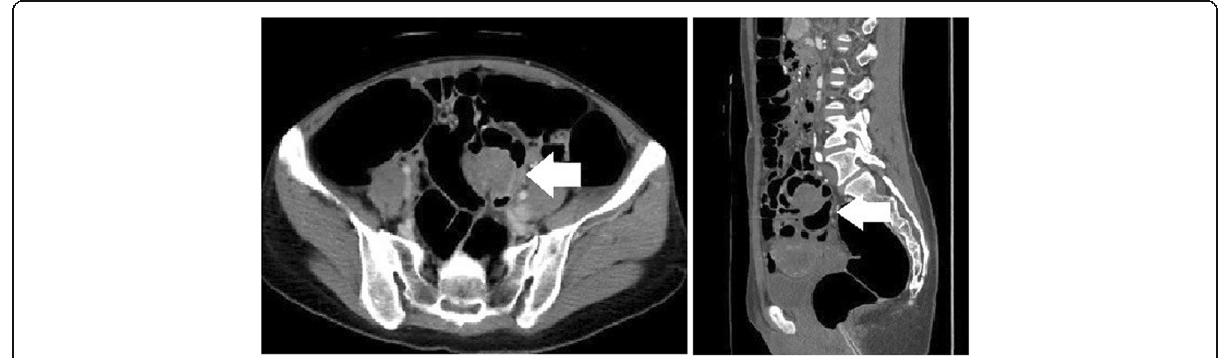
Fig. 10 Computed tomography shows the mass in the sigmoid colon